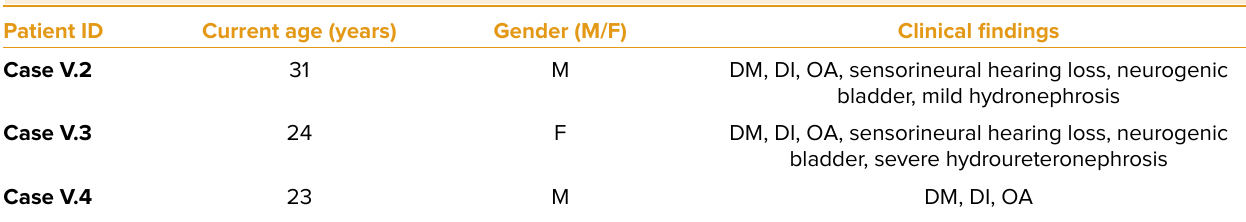
Figure 1. Pedigree information of the Wolfram syndrome family. Black filled shapes represent affected patients. Open shapes represent unaffected members. Table 1. Clinical features of patients with wolfram